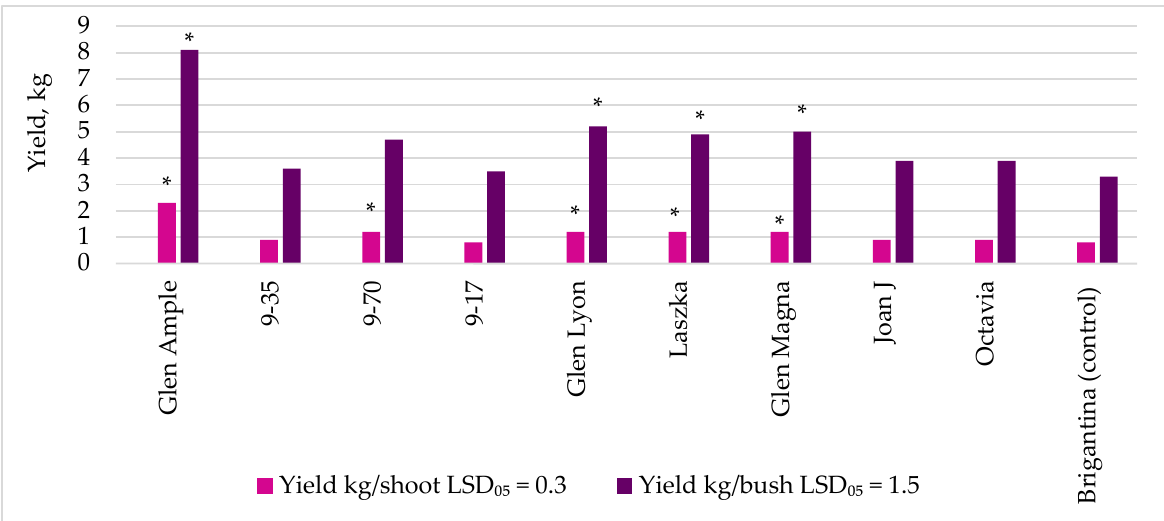
Figure 7. Yield per fruiting raspberry shoot and per bush, kg. (2019–2021). *—significant differences at the 5% significance level.